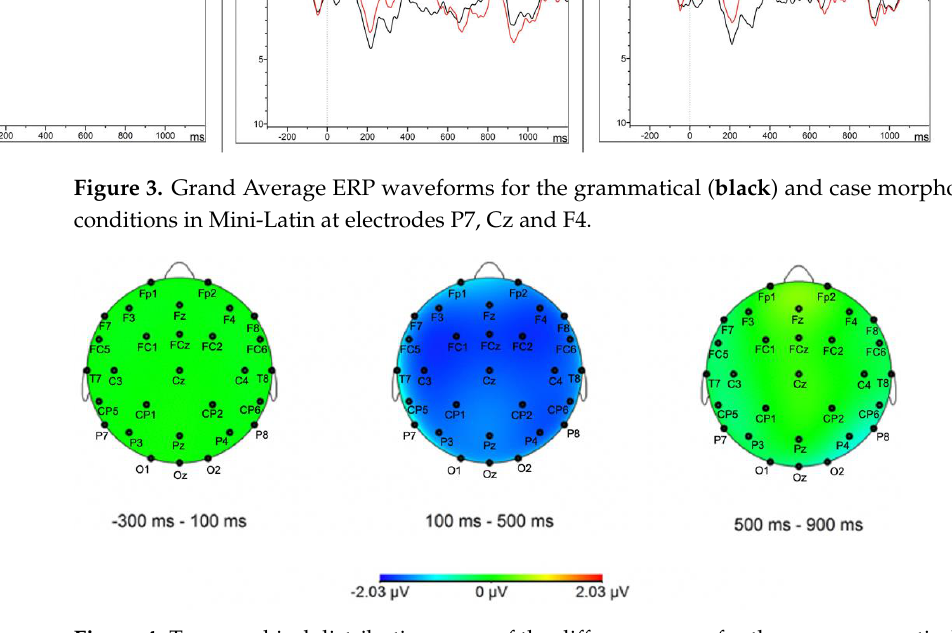
Figure 4. Topographical distribution maps of the difference wave for the case-grammatical condition contrast for the HSs group in the Mini-Latin experiment. All electrodes, apart from TP9/TP10 (offline references) and FT9/FT10 (falling outside of the +/ − 90 degrees plane due to sphericity constraints), are labeled in the topographic maps.